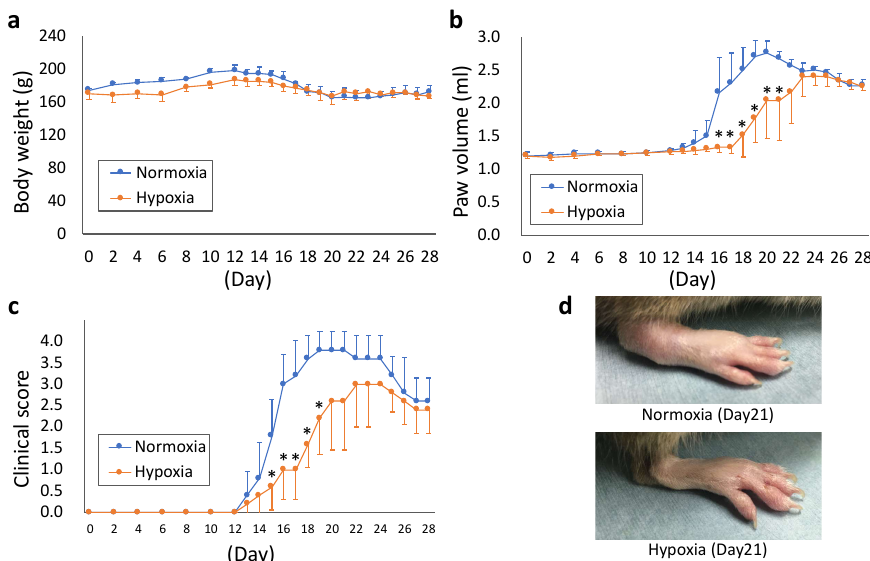
Figure 4. ( a–c ) Kinetic changes in body weight ( a ), paw volume ( b ), and clinical score ( c ) after immunization. The parameters were measured once every two days until day 12 and every day thereafter. (d) Representative images of arthrosis on day 21. Each value represents the mean ± SD (n = 5); * p < 0.05.